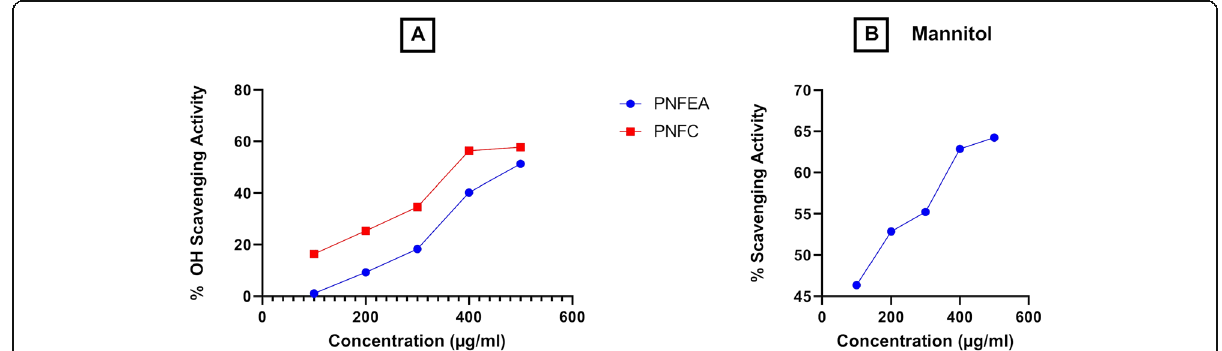
Fig. 5 Hydroxyl scavenging activity of a PNFC and PNFEA ( b ) mannitol